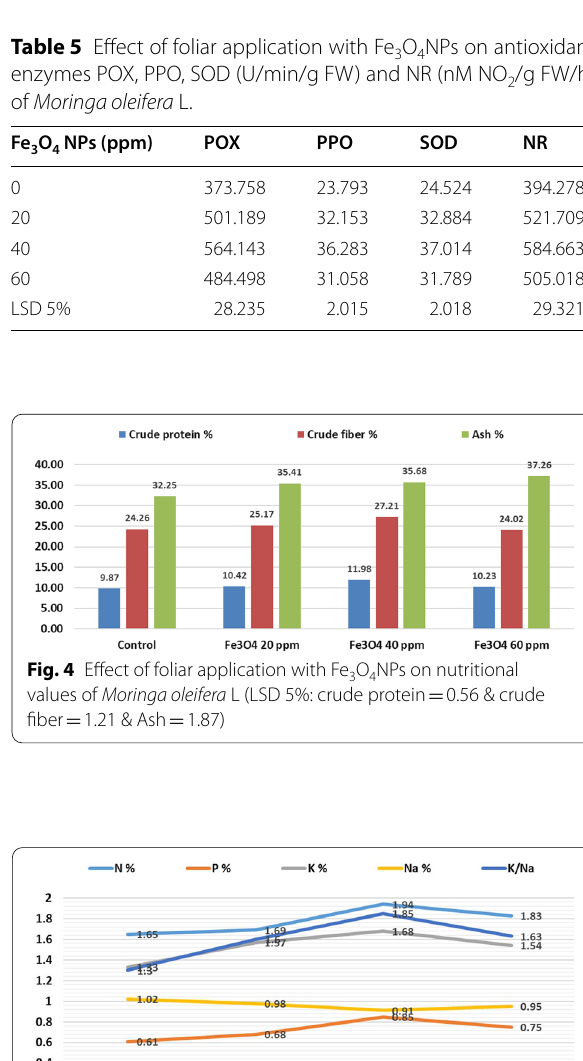
0.09, P % 0.06, K % 0.10, Na = = =